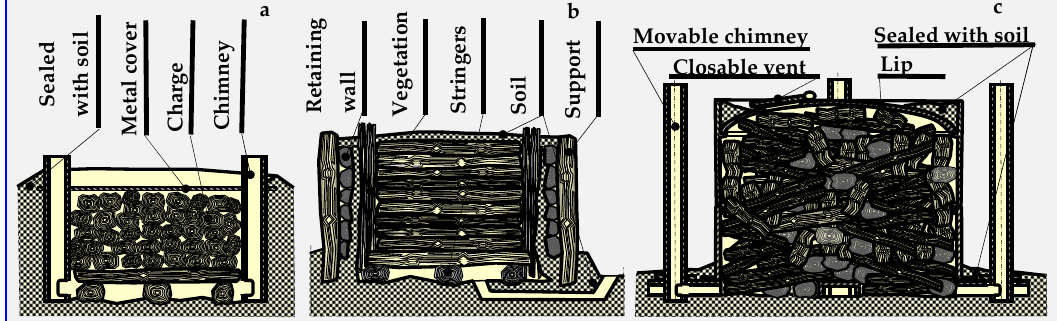
Figure 6. Schematic presentation of typical kilns: ( a ) pit, ( b ) traditional rectangular, ( c ) TPI transportable metal.